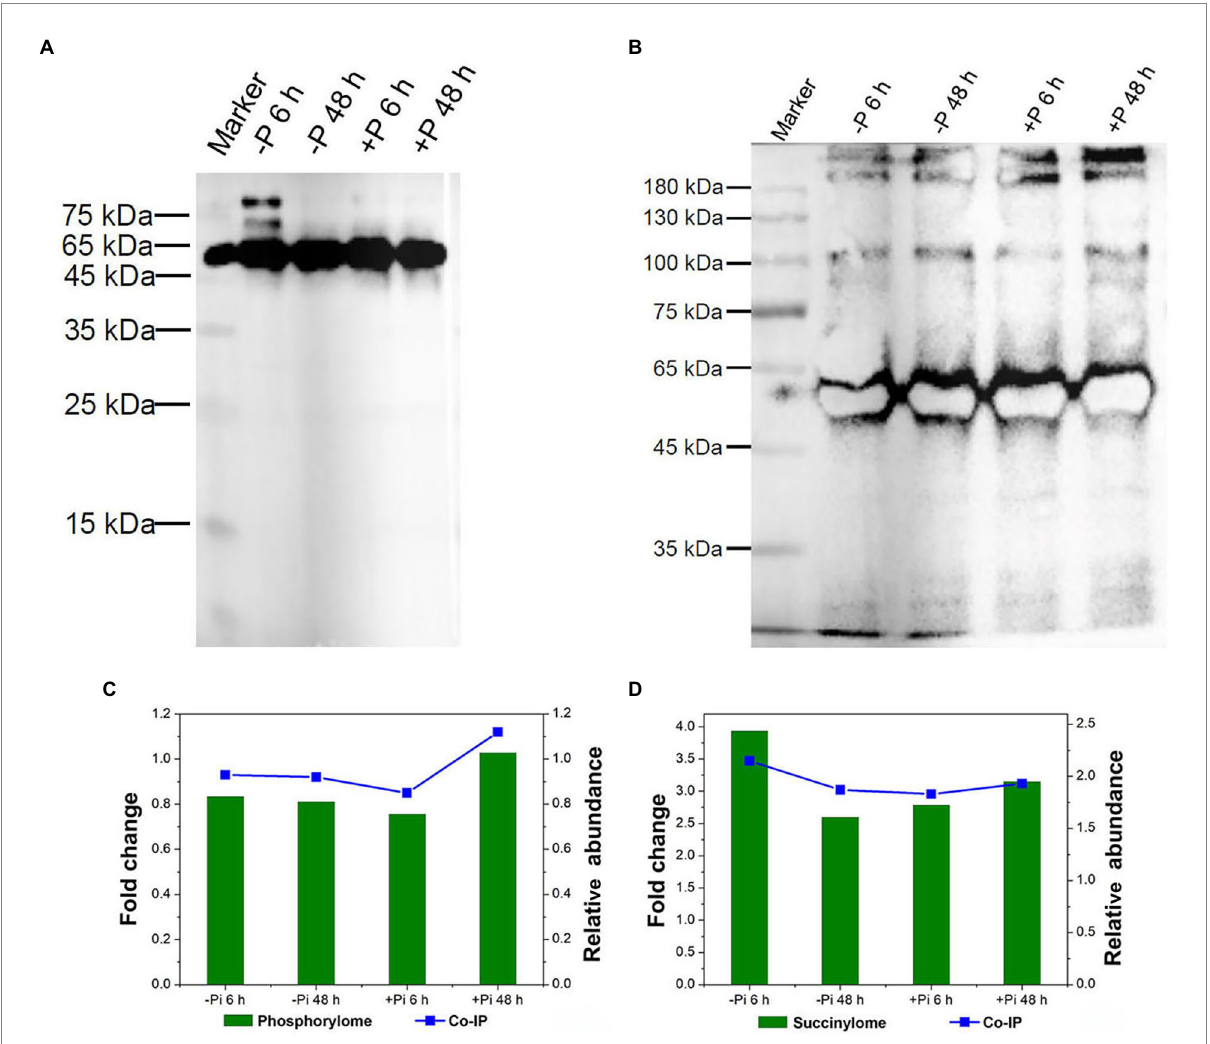
FIGURE 8 Validation of serine phosphorylation and lysine succinylation proteins in Pi starvation (–Pi) for 6 h and 48 h, and Pi recovery (+Pi) for 6 h and 48 h. Serine phosphorylation (A) and lysine succinylation (B) proteins were enriched by co-IP with phospho-serine and succinylated lysine polyclonal antibodies, respectively, followed by western blotting. Comparison of the phosphorylation (C) and succinylation (D) level of HORVU1Hr1G055440.1 in proteomic data (left Y-axis) and co-IP experiments (right Y-axis). Co-IP, co-immunoprecipitation; Pi, intracellular